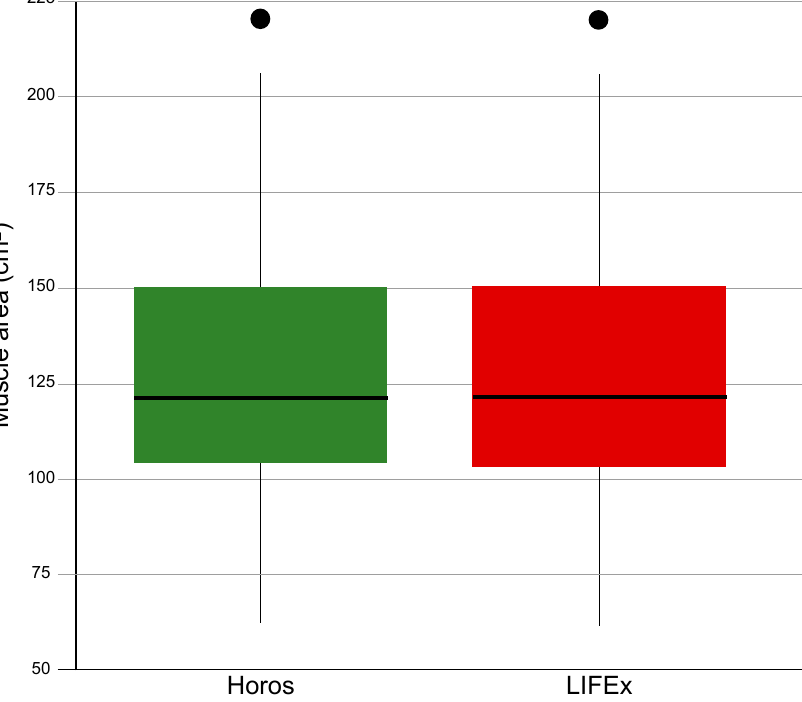
Figure 5. Boxplots of the muscle area values calculated by Horos and LIFEx. A continuous line represents the median, a colored zone delimits the interquartile range, and the a filled circle indicates an outlier.